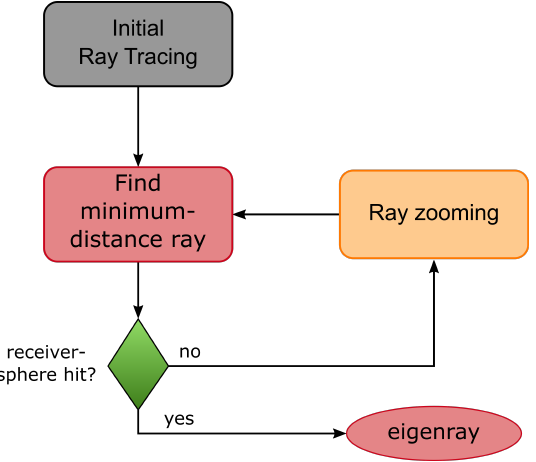
Figure 2. Block diagram of the adaptive ray zooming approach.